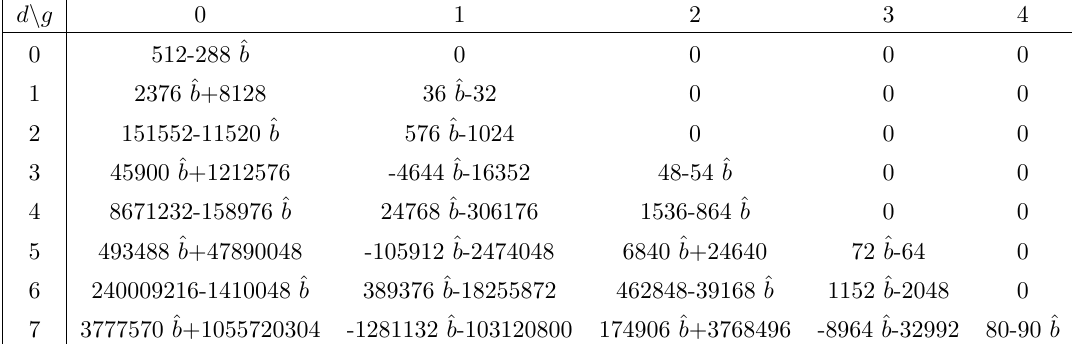
Table 2 . Gopakumar-Vafa invariants of the K 3 at base degree